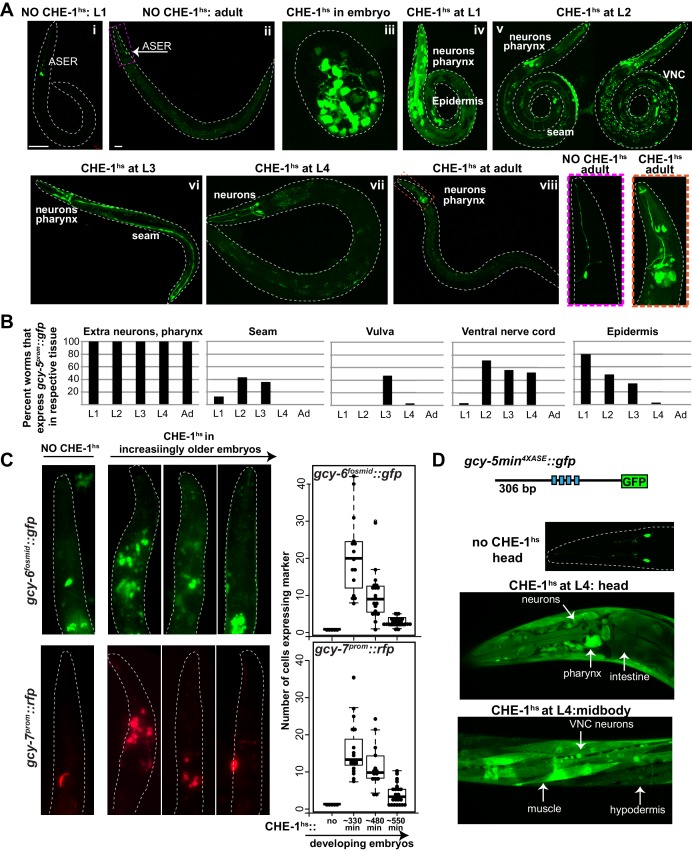
Expression of ASE markers in response to CHE-1hs at different developmental stages.(A) Expression of gcy-5prom::gfp becomes less broad as CHE-1hs is induced at later stages. (i) L1 worm without CHE-1hs, bright expression in ASER; (ii) adult without CHE-1hs, expression in ASER (arrow); (iii) embryonic CHE-1hs, broad gcy-5prom::gfp induction in deformed embryos; (iv) L1 CHE-1hs,expression of gcy-5prom::gfp in various tissues including hypodermis, various neurons, muscles, pharynx. (v) L2 CHE-1hs at two different focal points, gcy-5prom::gfp in seam, muscles, ventral nerve cord, other neurons and pharynx; (vi) L3 CHE-1hs, gcy-5prom::gfp in seam, vulva cells, neurons and pharynx; (vii) L4 and (viii) adult CHE-1hs, gcy-5prom::gfp is seen only in neurons and pharynx. Higher magnification of the heads in (i) and (viii). (B) Quantification of the expression of gcy-5prom::gfp in various tissues after CHE-1hs induction at various ages, as listed on the X-axis. n => 20 for each stage. (C) Expression of gcy-6fosmid and gcy-7prom in response to CHE-1hs at different stages. Quantification of the ectopic expression: every dot in this graph represents a worm and the number on the y-axis represents the total number of marker-expressing neurons counted. Ectopic expression decreases as the age of the embryos being heatshocked increases. (D) A synthetic ~300 bp region of the gcy-5 promoter in which the ASE motif has been multimerized four times can be broadly induced by CHE-1hs at all stages, including L4s, as shown here. Some of the tissues that express gcy-54XASE::gfp are labeled. gcy-54XASE::gfp is normally expressed only in the two ASEs.